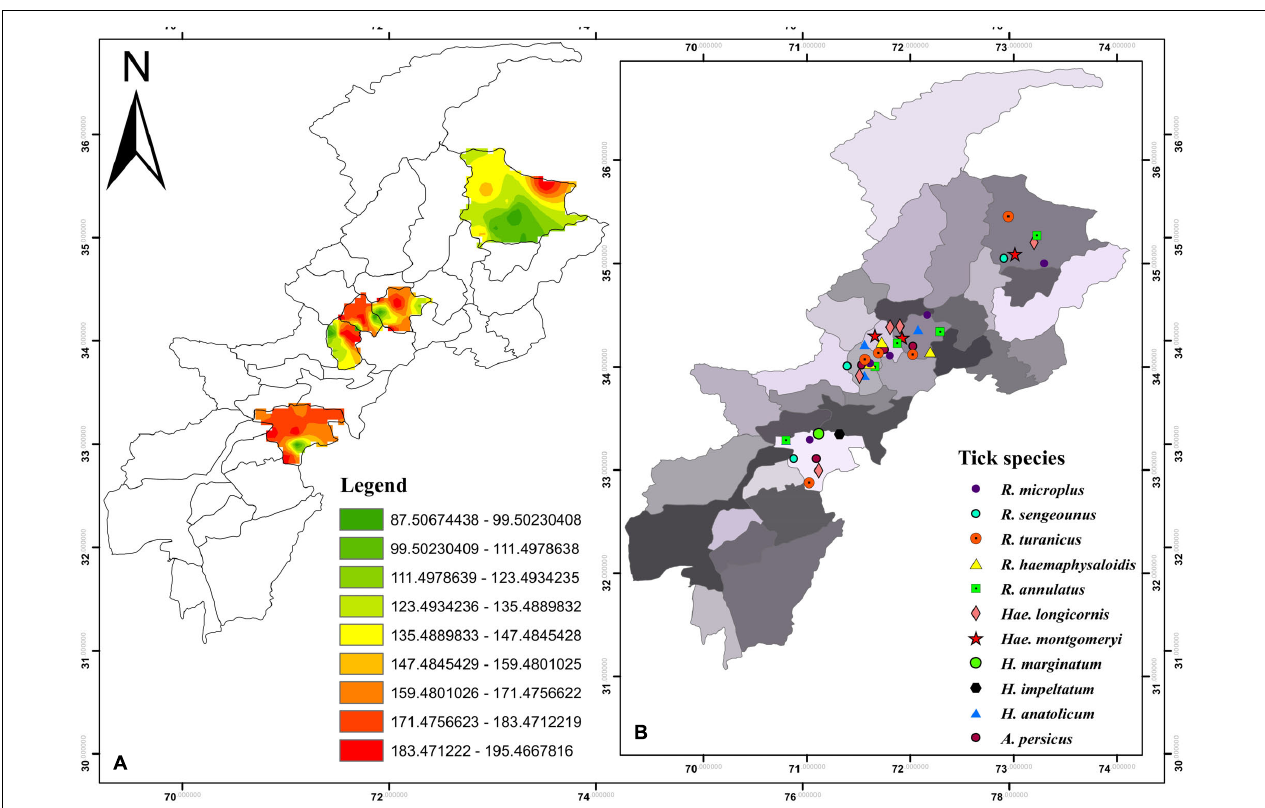
FIGURE 1 | (A) Density map of tick burden in the selected districts (B) and spatial distribution of tick species in